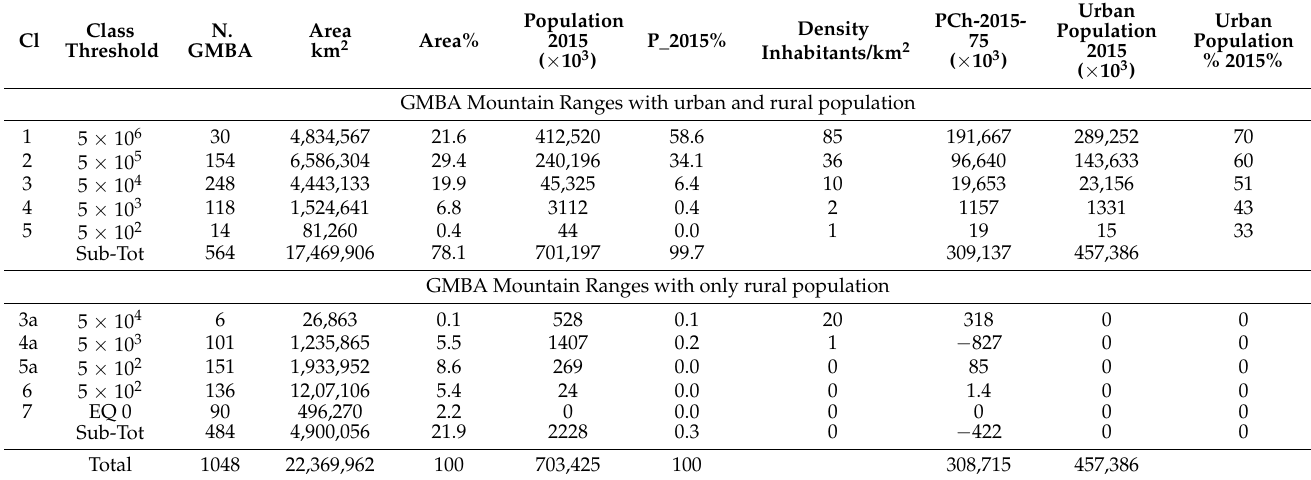
Figure 3. Population in 2015 ( y -axis) and surface area ( x -axis) both in logarithmic scale, for GMBA ranges with urban and rural population (red) and those with only rural population (green). The figure also shows the groupings of GMBA ranges in classes of population size. Ranges with above 5 million (Cl 1), between 500 thousand and 5 million (Cl 2), between 50 thousand and 500 thousand (Cl 3), between 5 thousand and 50 thousand (Cl 4), between 500 and 5 thousand (Cl 5), and that with fewer than 500 people (Cl 6). Table 2. Overview of the population in the 958 populated GMBA ranges grouped in classes of